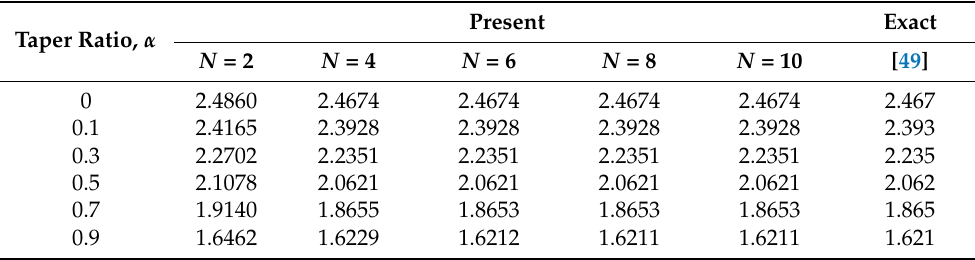
Table 1. Comparison and convergence of dimensionless critical buckling loads for homogeneous tapered cantilever microbeams ( l 0 = l 1 = l 2 = 0). Taper Ratio, α